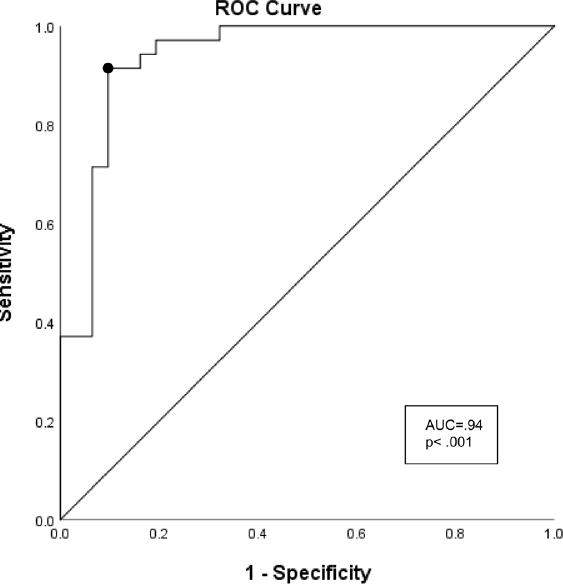
Figure 5. The receiver operating characteristic curve of the fellow eyes of PCV with choroidal vascular hyperpermeability and controls. The circled point is the best cut-off point. Youden index = 0.56, sensitivity = 91.4%, specificity = 86.0%. The area under the curve (AUC) = 0.94 (95% CI 0.88–1.00) (P <